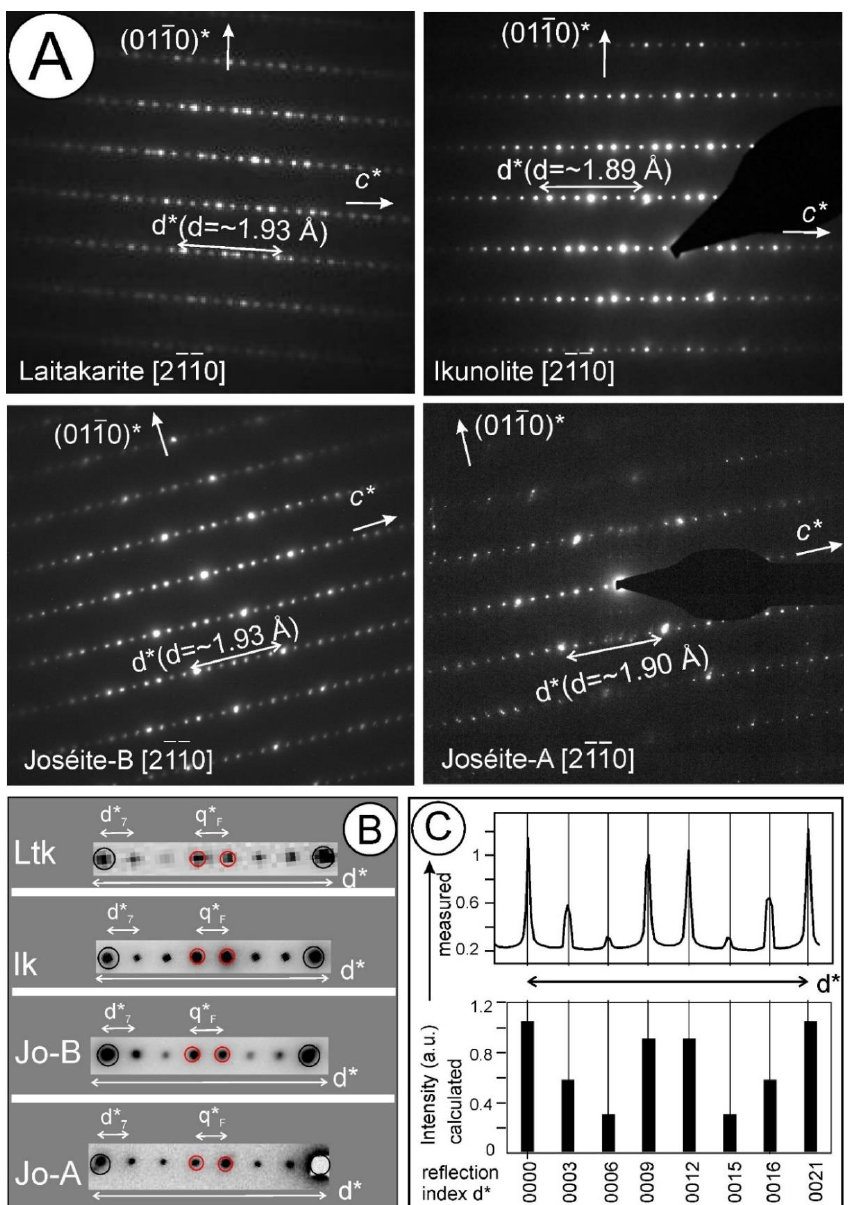
Figure 7. ( A ) Selected area electron diffraction (SAED) on the [21̅1̅0] zone axis for each of the species shown in Figure 6. Note the slight variation in measured d values (d = 1/d*) in the range 1.89–1.93 Å . ( B ) Details on the reflection distribution and intensity variation along the interval d* obtained from each SAED in (A). Note d* 7 = q* F in all four species. ( C ) Plots showing the match between variation in reflection intensity along d* for ikunolite (upper part) and calculated values for the sum of intensities for the seven-atom layer obtained from [2] (lower part). Indexing along the x axis with respect to the seven-atom-layer superstructure.